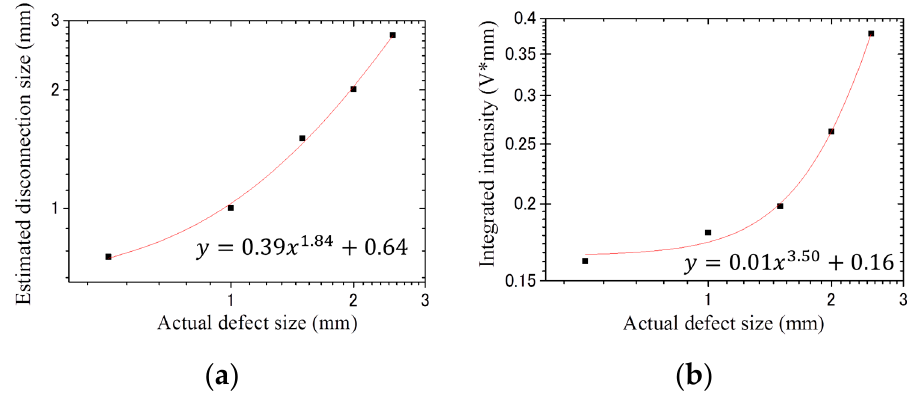
Figure 4. ( a ) Relationship between actual defect width and estimated defect width; ( b ) Relationship between actual defect width and integrated intensity.